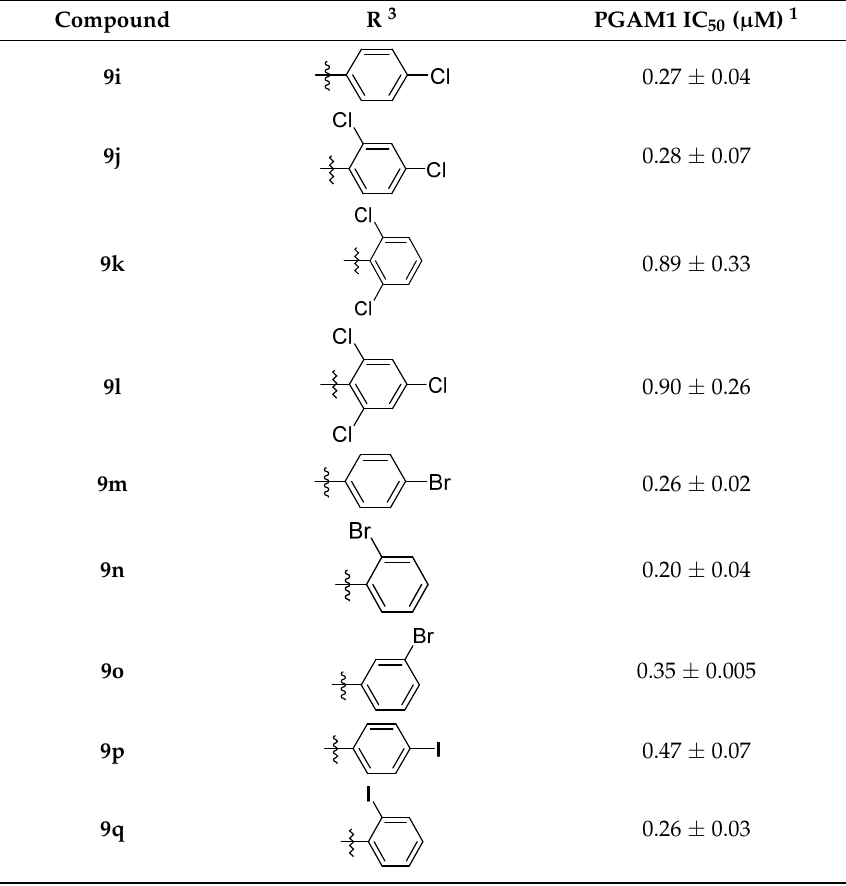
Table 3. Inhibition activity of compounds 14a – 14g towards PGAM1.